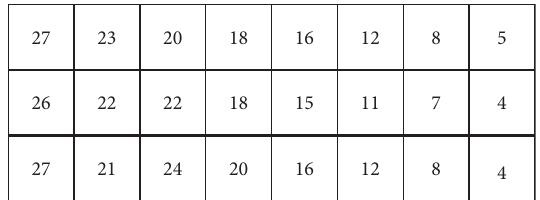
Figure 3: A hypothetical sector is divided into a subregion in our segmentation